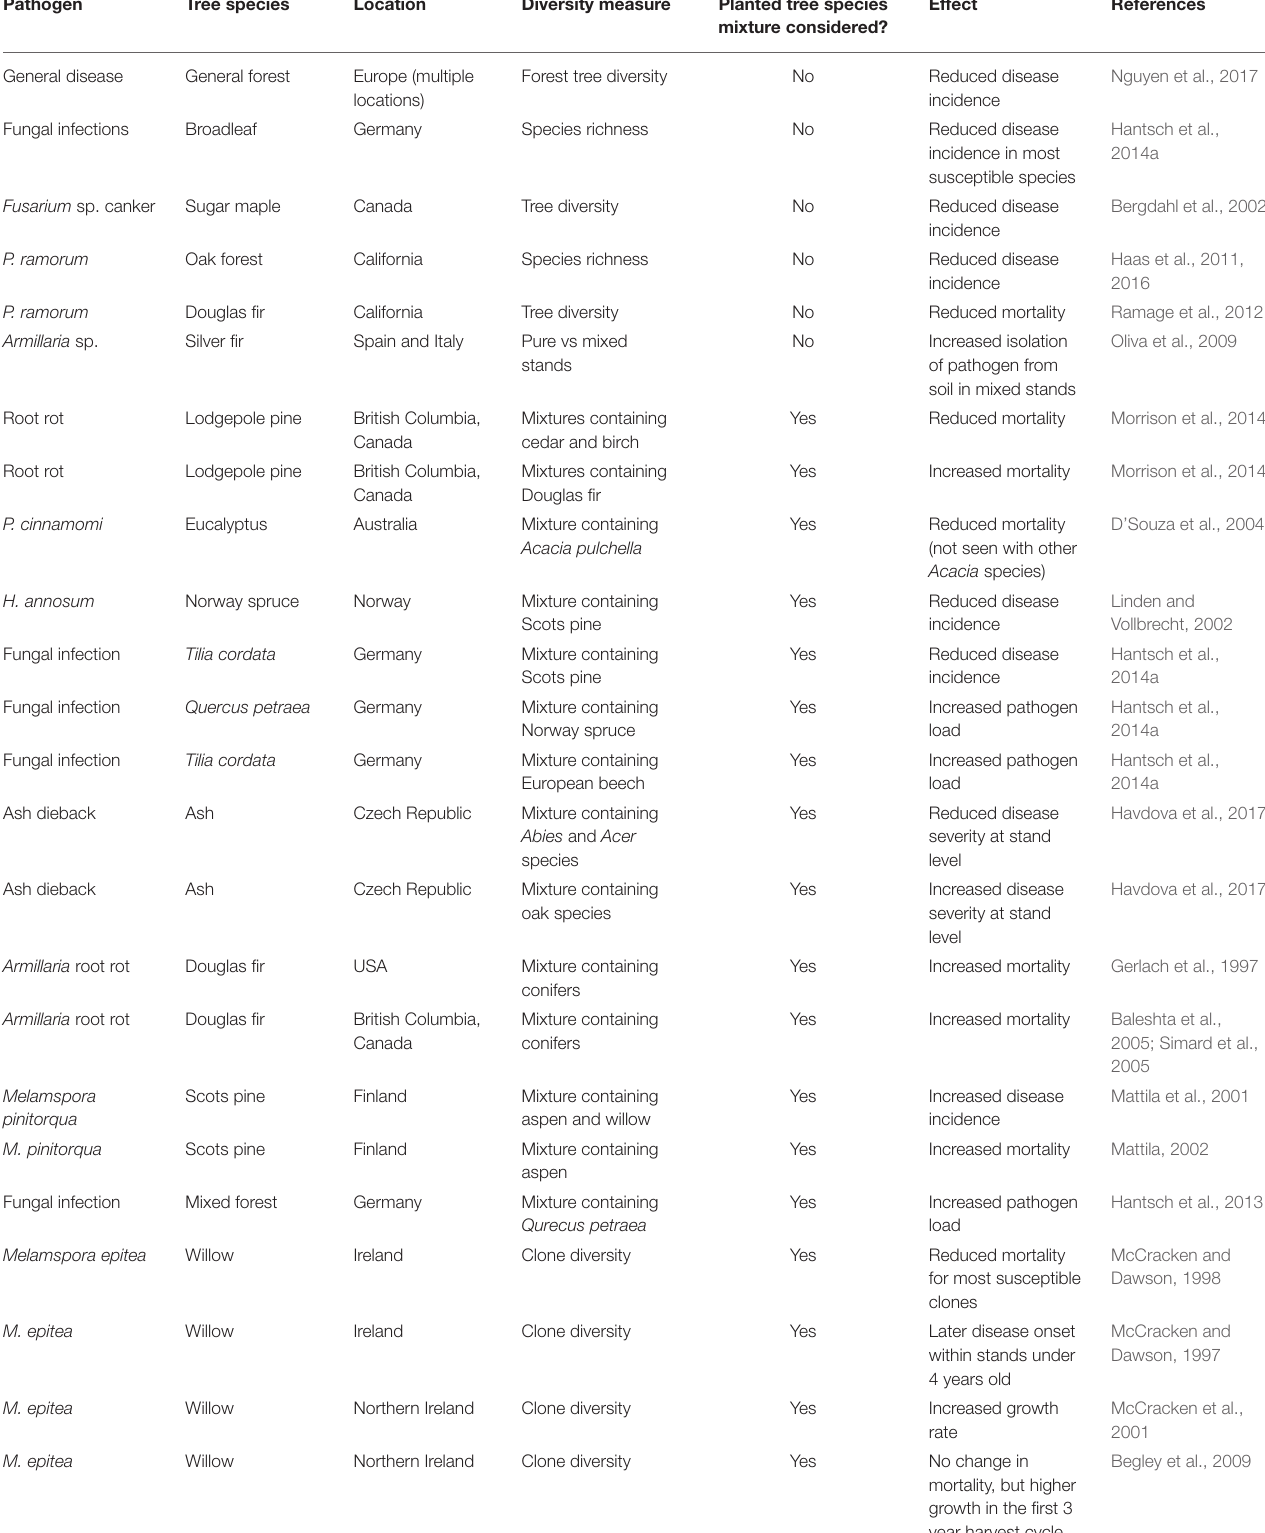
TABLE 3 | Summary of studies in tree species diversity/mixture